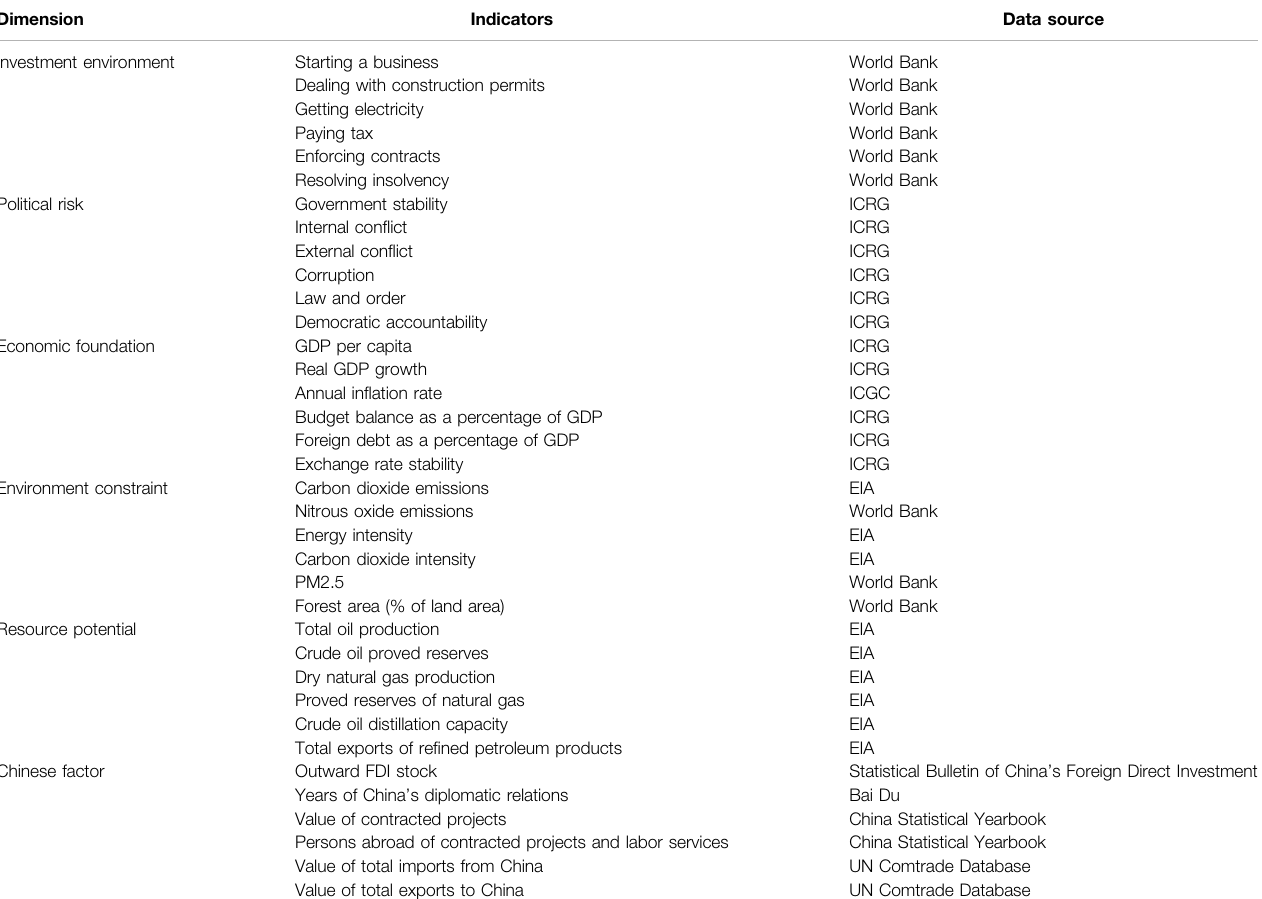
TABLE 1 | Investment risk assessment indicators.